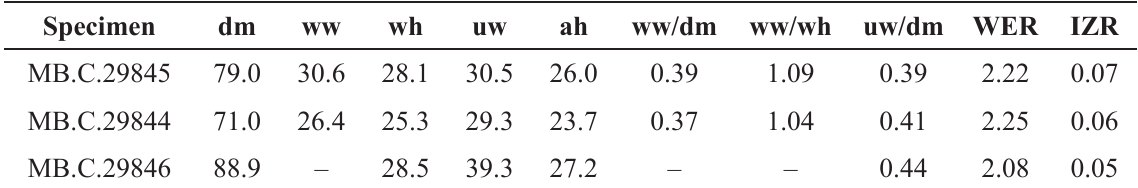
Table 15. Conch dimensions (partly estimated) and ratios of selected specimens of Paratirolites trapezoidalis Shevyrev, 1965 from Baghuk Mountain.